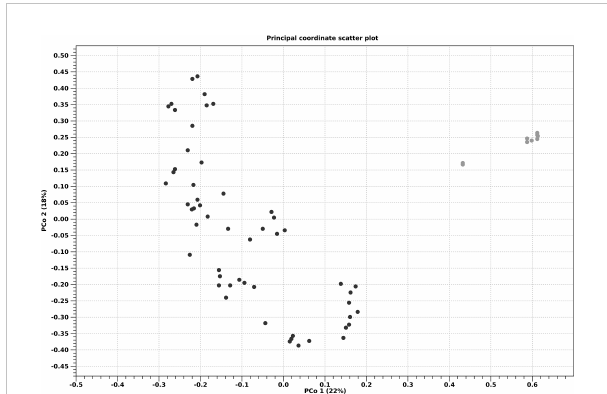
FIGURE 7 Principal coordinate analysis ordination (PCoA) of a Bray-Curtis dissimilarity matrix for adult thalli (gray) and seedlings